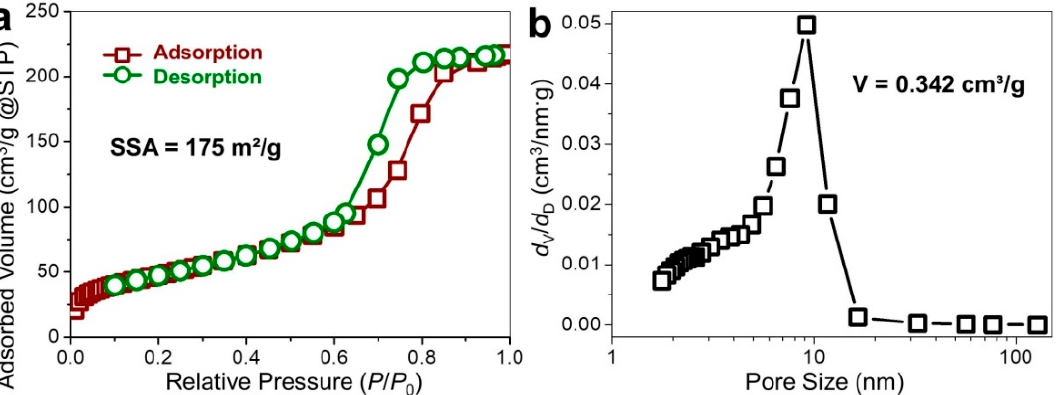
Figure 4. Porosimetry on graphene deposited on MgO. ( a ) N 2 adsorption-desorption isotherms as a function of equilibrium relative pressure and ( b ) pore size distribution of graphene after etching the host MgO templates.